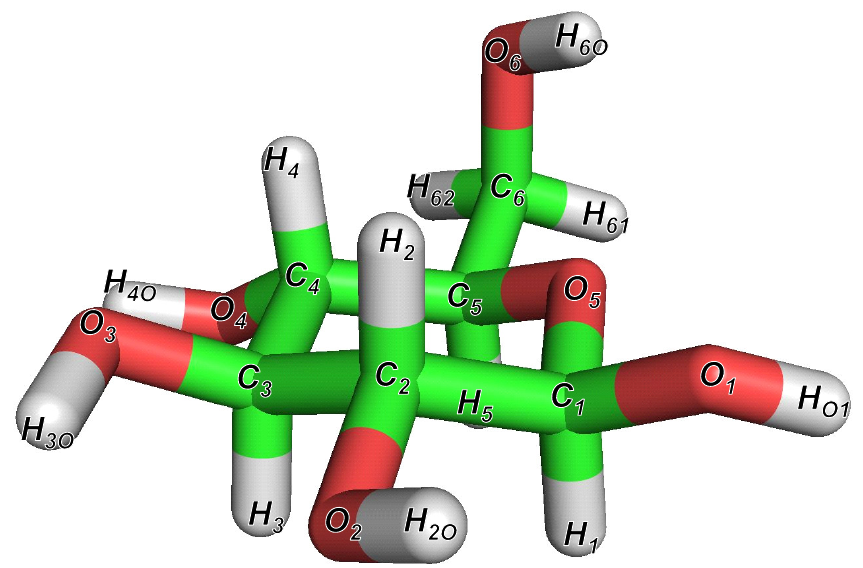
Figure 2. The most stable structure of β -glucose at B3LYP/6-31++G(2d,2p) DFT computation level. This structure has the same characteristics as the most stable structure reported by Alonso et al. [33].